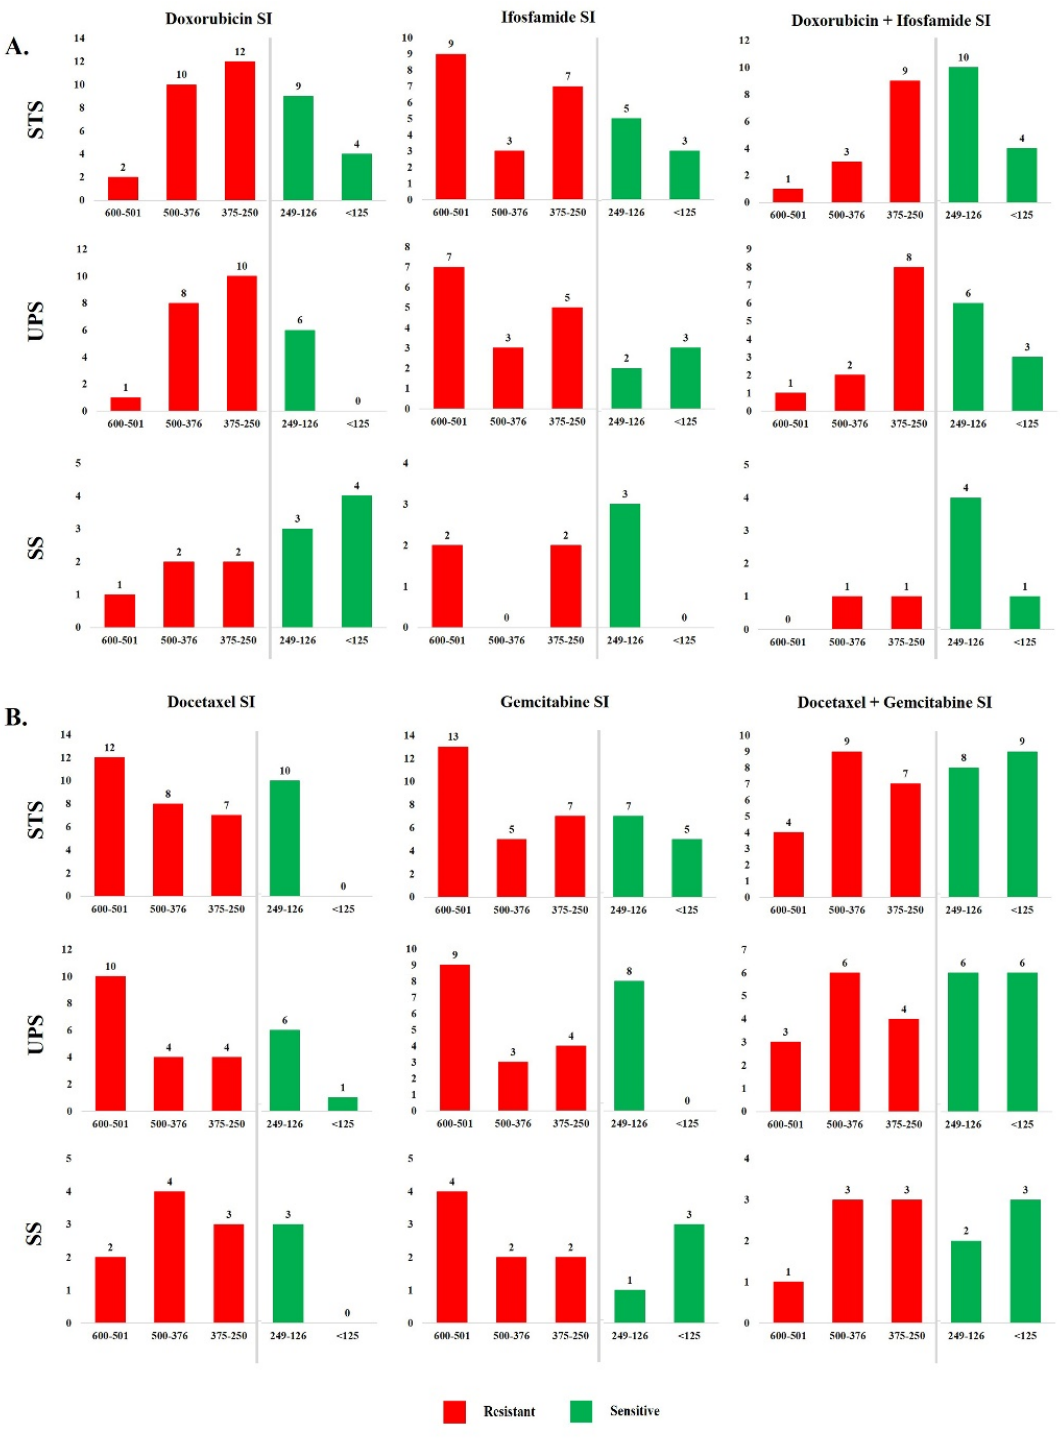
Figure 1. Histograms of SI frequencies of STS primary cultures for chemotherapeutic drugs and their combinations. ( A ). Number of SS, UPS, and STS primary cultures in the groups formed by SI to Dox, Ifo, and DOX + IFO; ( B ). Number of SS, UPS, and STS primary cultures in the groups formed by SI to Doc, Gem, and Doc + Gem. Red color indicates resistance; green color indicates sensitivity to the drugs.